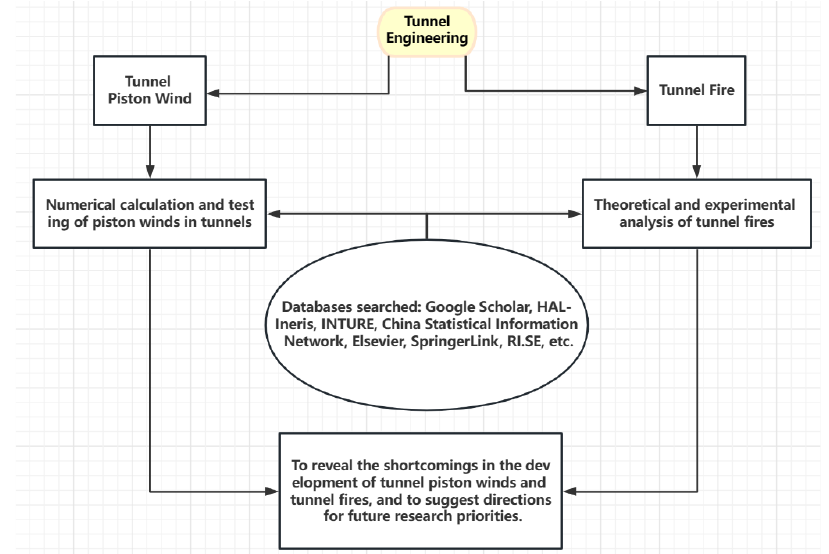
Figure 3. Flow chart of the study.